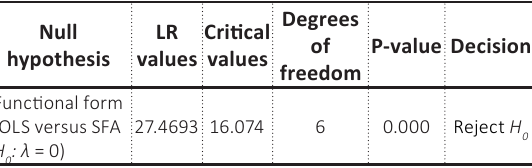
Table 4. Log-likelihood ratio test – selecting SFA versus OLS model